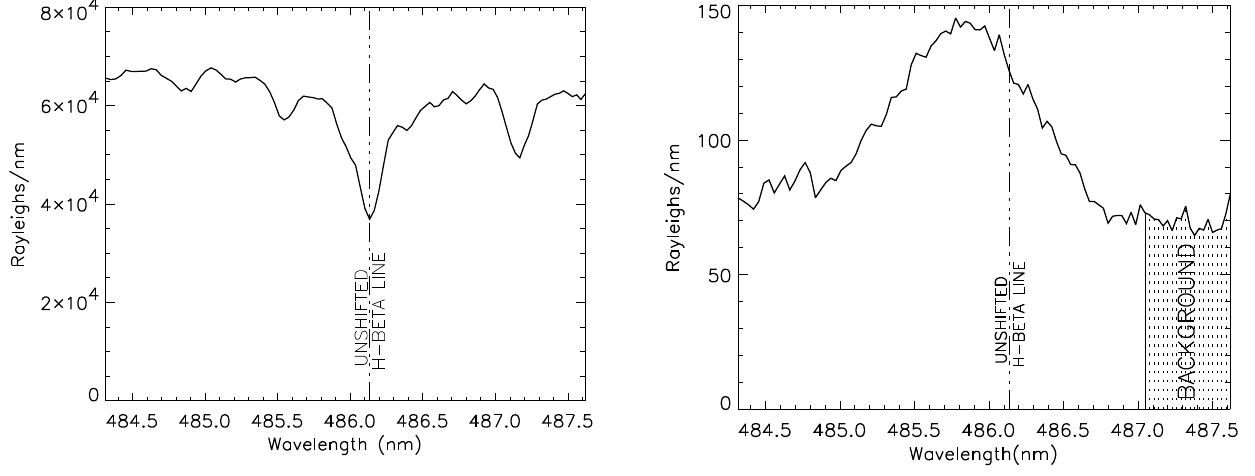
Fig. 3. An example Hydrogen β profile. The shaded area indicates the chosen background region of the